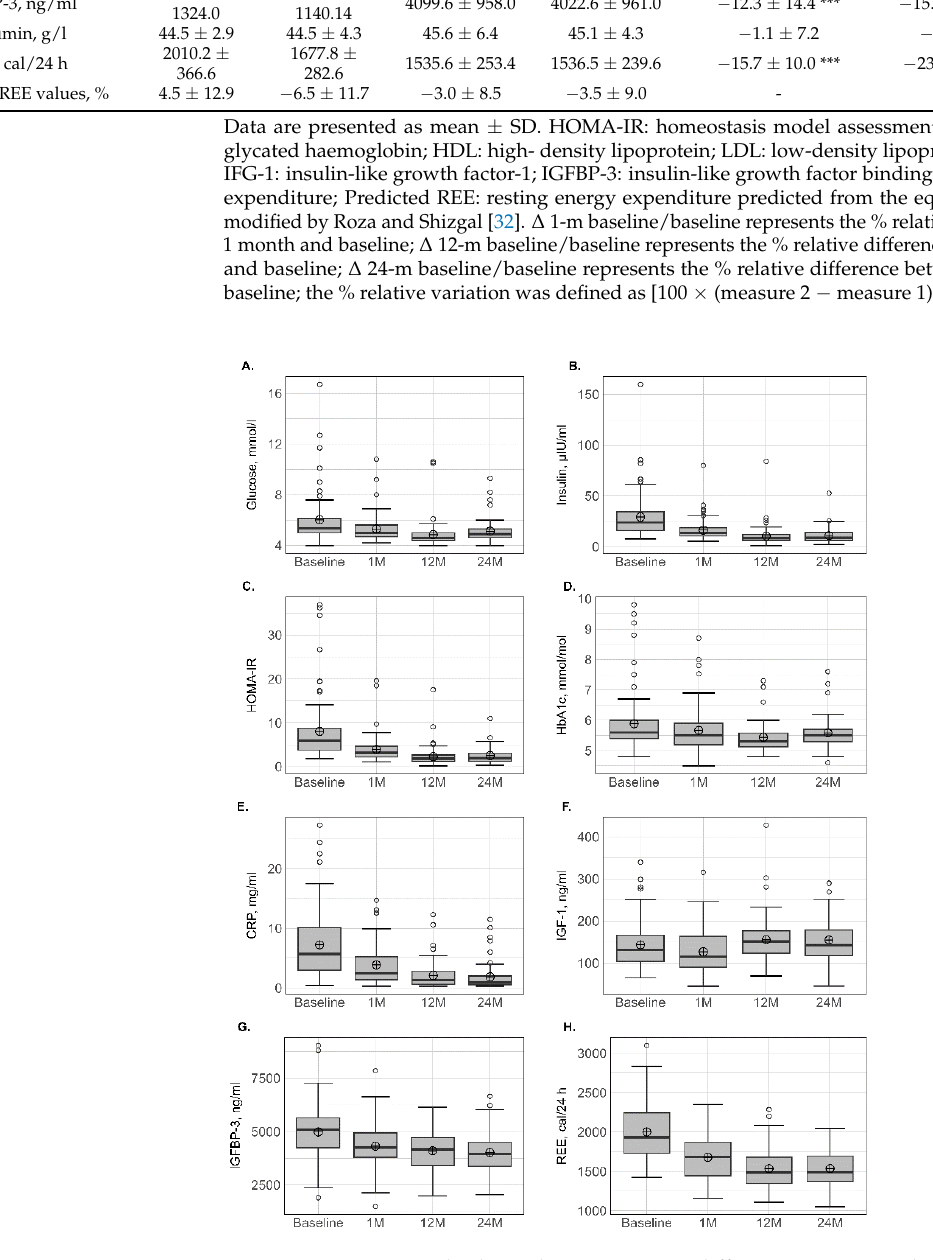
Figure 2. Variation in biological parameters at different times. BMI: body mass index ( A ); FM: fat mass ( B ); LTM: lean tissue mass ( C ); LTM/FM ratio ( D ); ALM: appendicular lean mass ( E ); ALMI(h 2 ): appendicular lean mass index (height 2 ) ( F ); ALM/height 2 , ALMI(BMI) ( G ): appendicular lean mass index (BMI); TAT: total adipose tissue ( H ); VAT: visceral adipose tissue ( I ); SAT: subcutaneous adipose tissue ( J ). Lower whisker represents the smallest observation greater than or equal to lower hinge −1.5 × IQR. Upper whisker represents the largest observation less than or equal to upper hinge + 1.5 × IQR. Lower and upper hinges represent, respectively, the 25 and the 75% quartile values. The open circles represent the mean value in each time. Data beyond the end of the whiskers are called outlier points and are plotted individually. IQR, interquartile range.